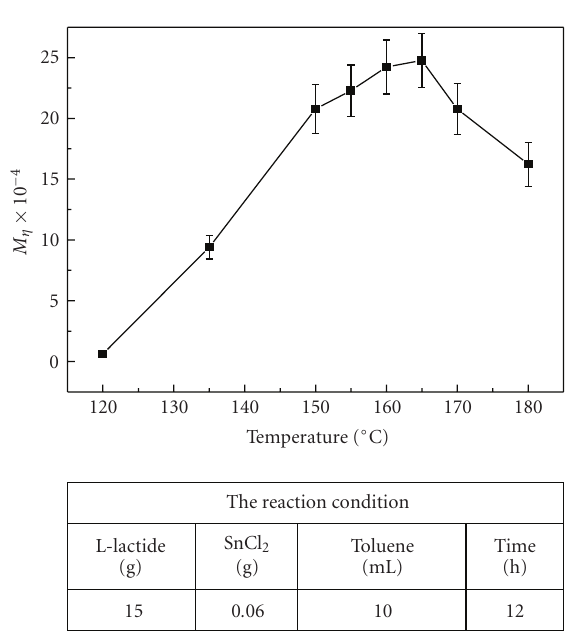
Figure 4: The relationship between the reaction temperature and M η of PLAs.